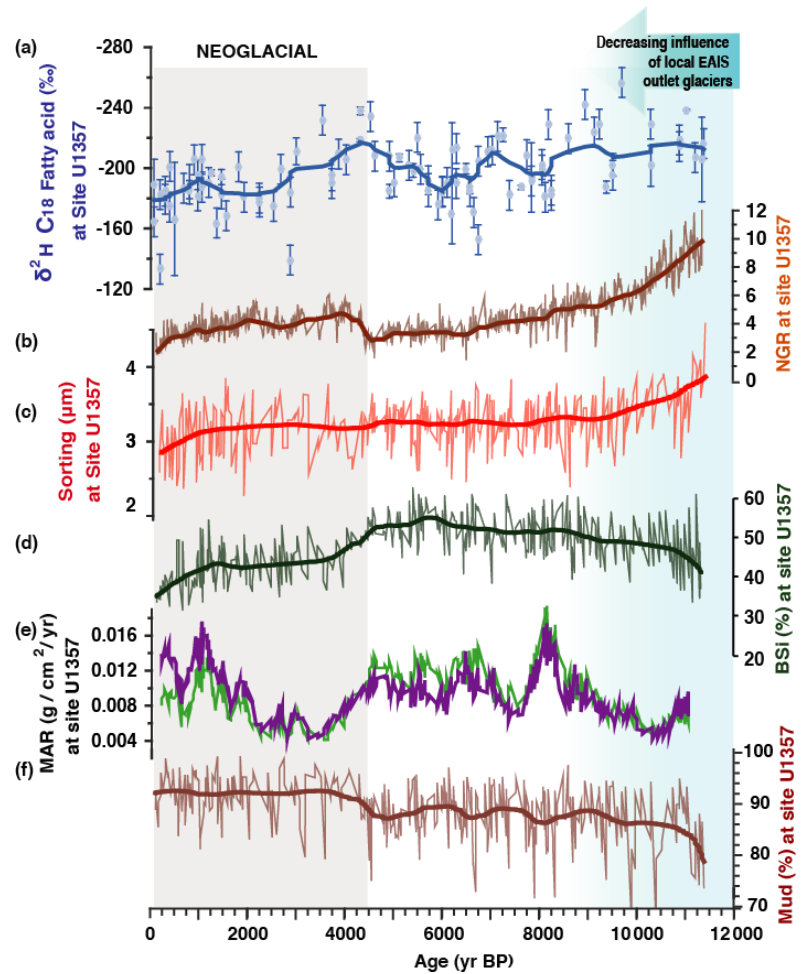
Figure 5. Holocene Adélie Land proxy records from IODP Site U1357 (a) C 18 fatty acid δ 2 H (errors bars based on replicate analyses); the heavy line is a robust locally weighted scatterplot smoothing (rlowss). (b) Natural Gamma Radiation; the heavy line is a rlowss . (c) Grain sorting (µm) calculated following Folk and Ward (1957); the heavy line is a rlowss. (d) Percentage of biogenic silica (BSi); the heavy line is a rlowss. (e) Mass accumulation rates of biogenic (green line) and terrigenous (purple line) material (f) Percentage of mud; the heavy line is a